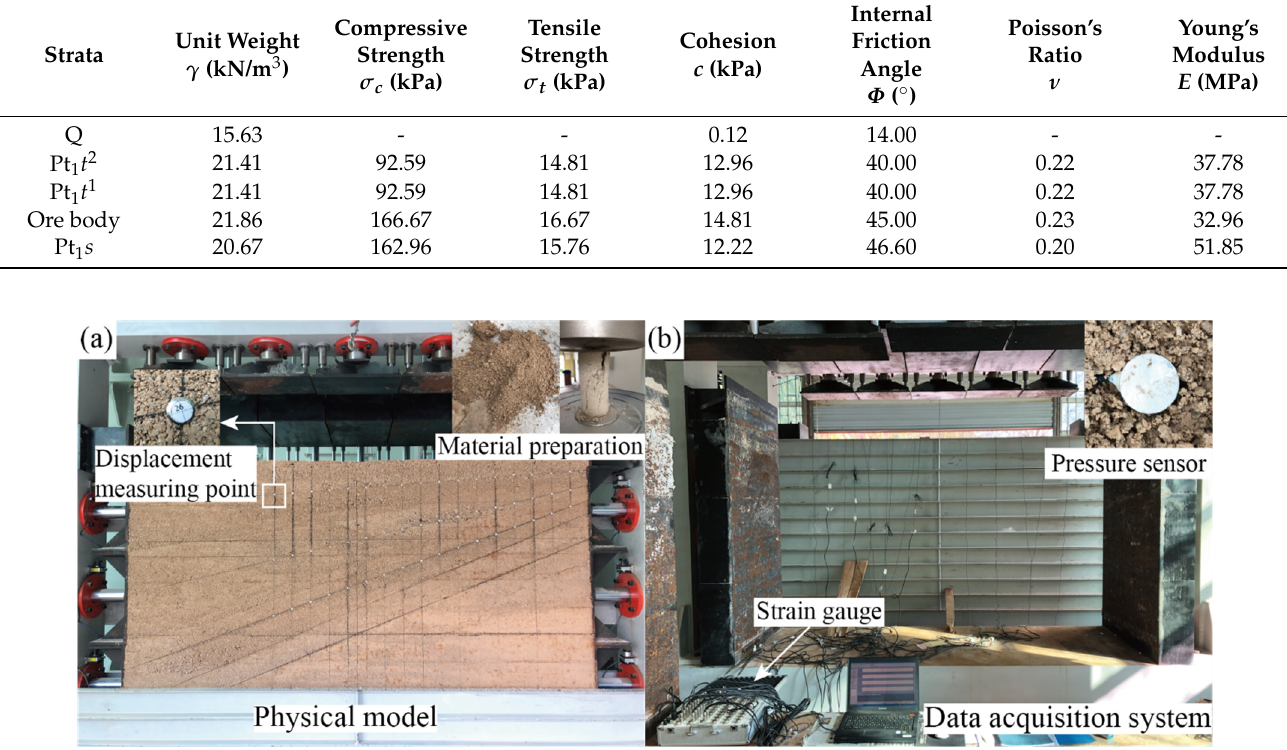
Figure 2. The physical model and data acquisition system: ( a ) Physical model; ( b ) Data acquisition system (Pressure sensors: LY-350; Measuring range: 0–100 kPa; Resolving power % F·S ≤ 0.05; Overall dimension: 28 × 9 mm; Impedance: 350 Ω ).